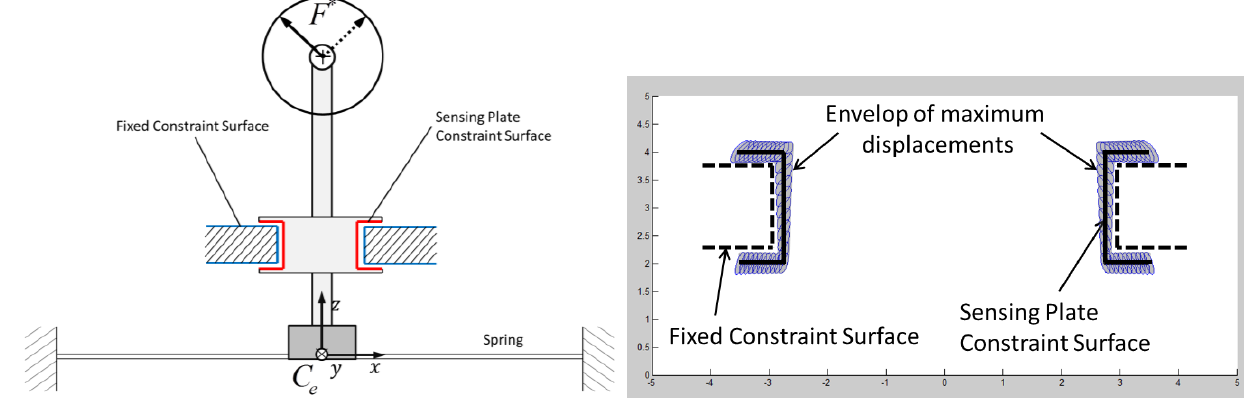
Figure 9. Scheme of the working principle for the adopted overload protection mechanism. The overload protection is located between the spring and the sensing-point. On the right side it is shown how the fixed constraint-surface was chosen to comply with the displacement envelope.